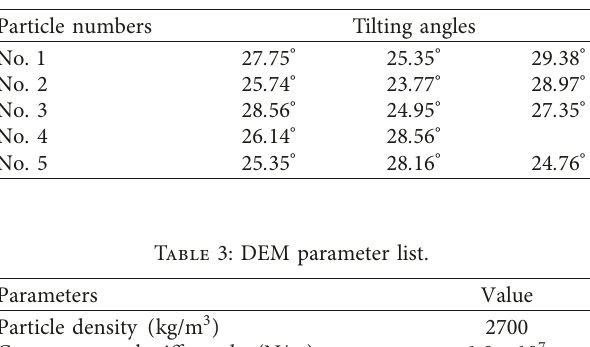
Figure 9: Measurement of coefficient of friction between wall geometry and particles. (a) Five ballast particles. (b) The sliding test. Table 2: Tilting angles for five ballast particles.